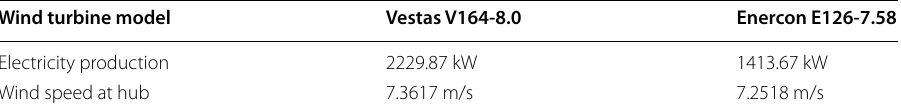
Table 3 Scenario 2 wind turbine results